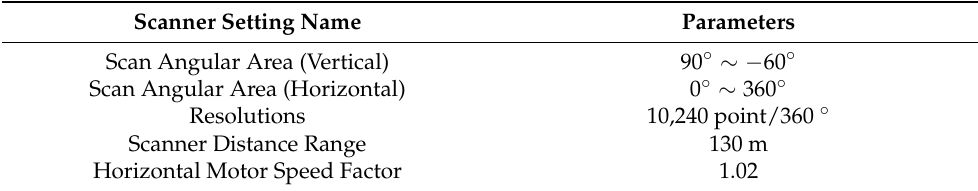
Table 1. Scanner setting